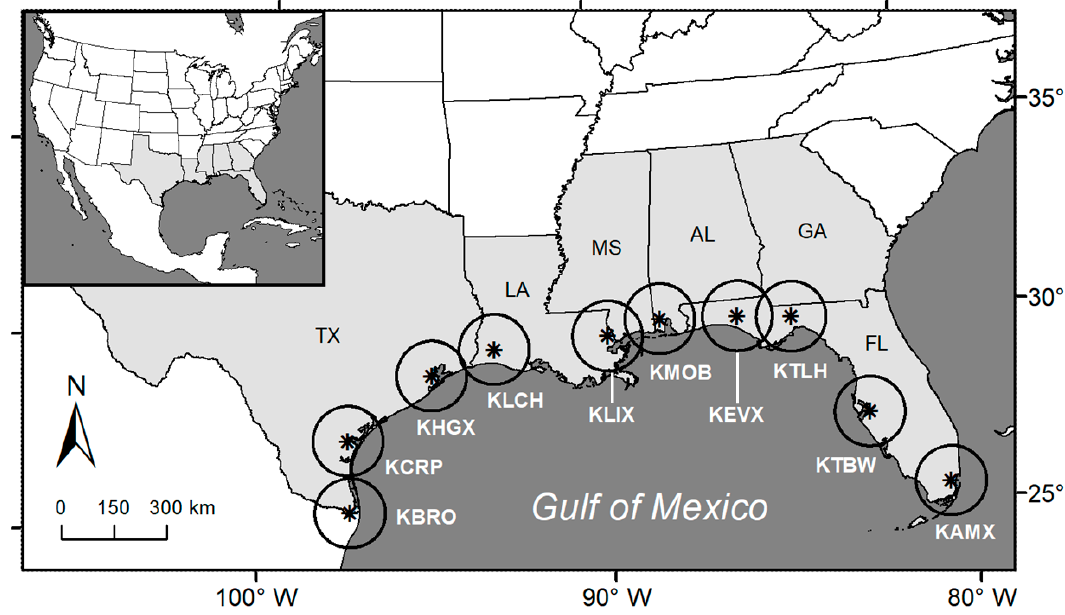
Figure 1. The locations and coverage of the 10 NEXRAD sites (the circles represent a 100-km radius sampling area) within the northern Gulf of Mexico coastal region, which encompasses six states: Texas (TX), Louisiana (LA), Mississippi (MS), Alabama (AL), Georgia (GA), and Florida (FL).